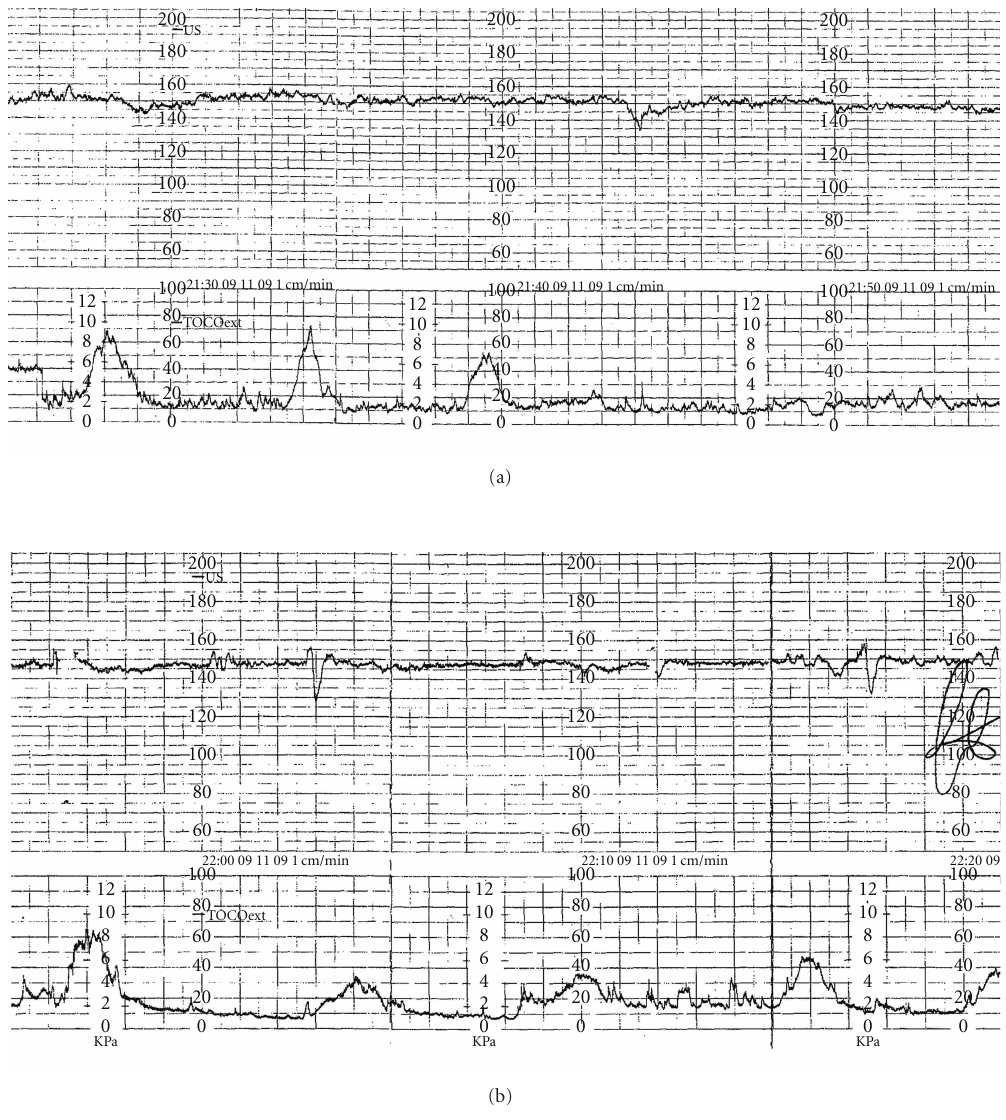
Figure 1: Fetal heart rate monitoring: (a,b). Persistent decreased variability ( < 5bpm).